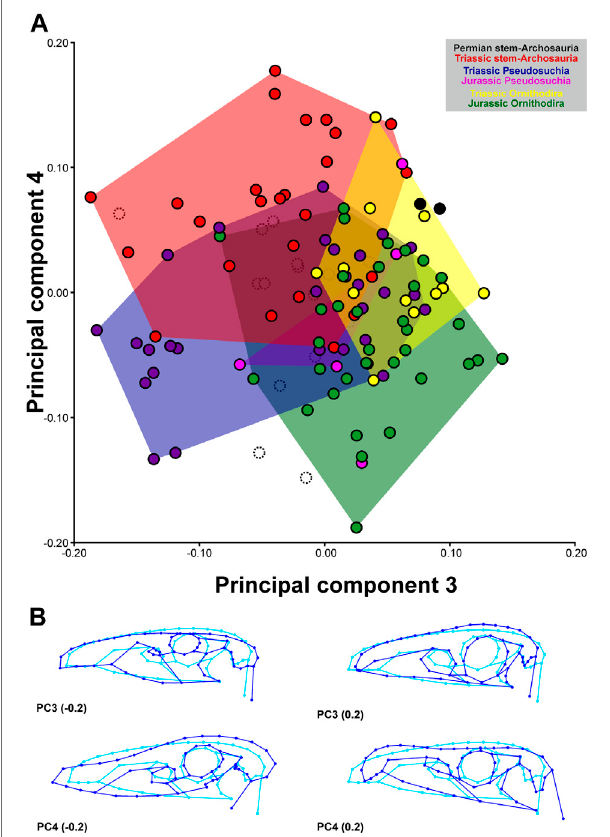
FIGURE 3 | Two − dimensional morphospace (A) and major shape variation (B) of the archosauromorph cranium captured by 2D geometric morphometrics based on the third and fourth principal component. The morphospaces (convex hulls) of stem-archosaurs, pseudosuchians and avemetatarsalians during different time periods are differently colored. White points with dashed outline represent Cretaceous taxa that have been used to estimate hypothetical ancestral shapes for the Late Jurassic. Blue wireframes show major shape variation of the principal components compared to the consensus shape shown in